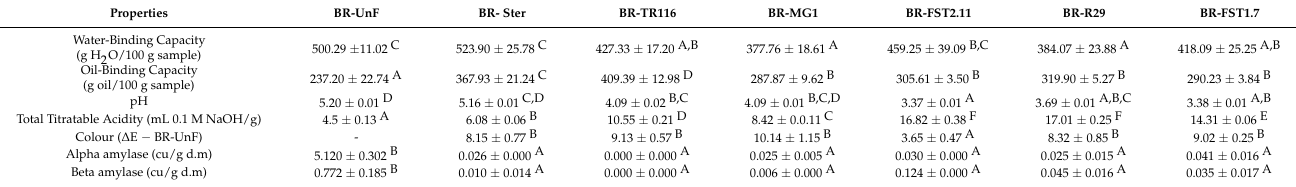
Table 3. Analysis of the functional properties of rootlet ingredients. BR-UnF and BR-Ster represent un- fermented barley rootlet and sterilised barley rootlets, respectively. BR-TR116, BR-MG1, BR-FST2.11, BR-29 and BR-FST1.7 represent barley rootlets fermented with: Leuconostoc citreum TR116, Weissella cibaria MG1, Lactobacillus amylovorus FST2.11, Limosilactobacillus reuteri R29 and Lactiplantibacillus plantarum FST1.7, respectively. The values in the table represent the mean + standard deviation. No statistical difference was found with values in the same row which share the same uppercase